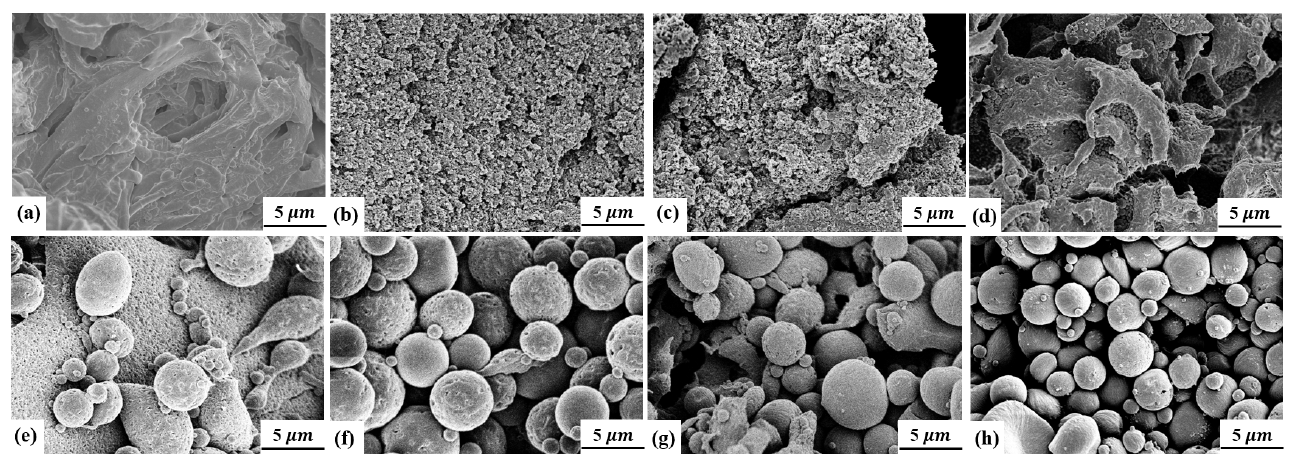
Figure 1. Morphology evolution of LC4/LA(50/50) after being statically molten for various durations: ( a ) 0 min, directly out of the TSE (AFM-IR image); ( b ) 0 min, directly out of the TSE (SEM image); ( c ) 1 min; ( d ) 2 min; ( e ) 3 min; ( f ) 5 min; ( g ) 7 min; ( h ) 10 min.